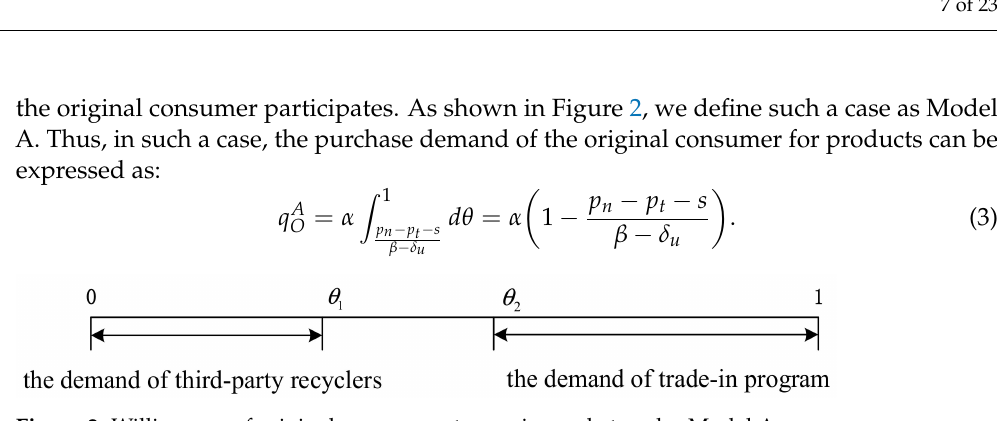
Figure 2. Willingness of original consumers to pay in market under Model A.